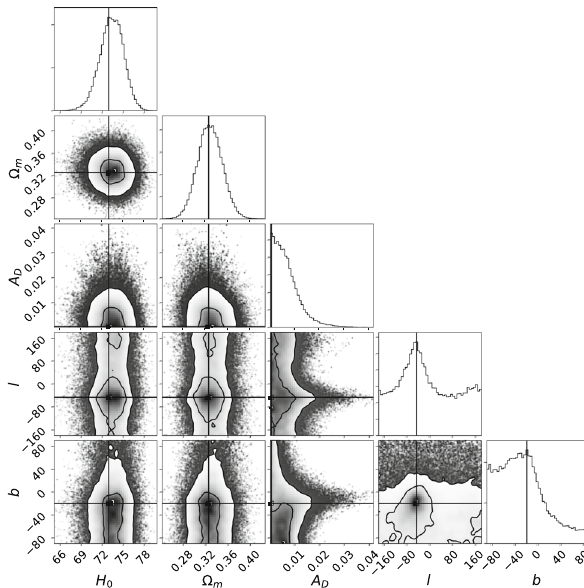
Fig. 8 The marginalized posterior distribution of the parameters in the Finslerian cosmological model with the combination of 2020 quasar compilation, Pantheon sample, and six gravitationally lensed quasars. The horizontal and vertical solid black lines denote the maximum of 1-dimensional marginalized